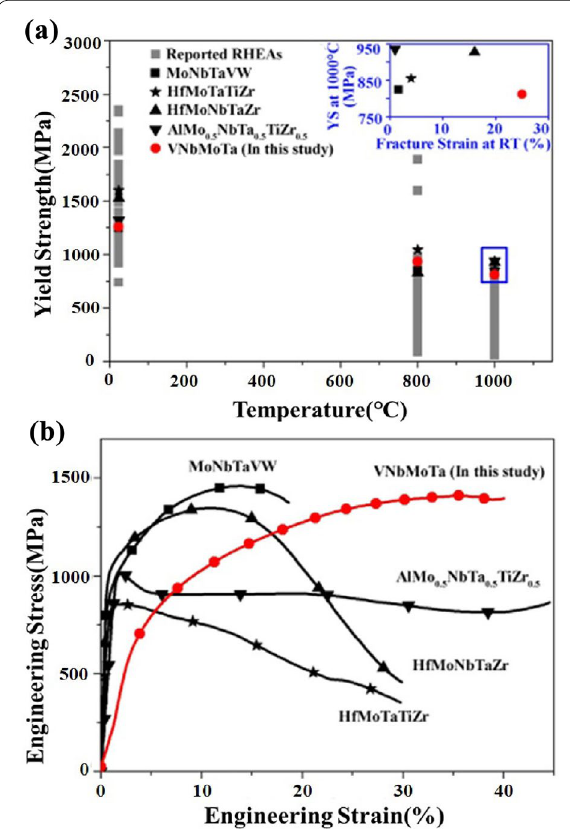
Figure 1 ( a ) Yield strengths of V1.0 RHEA and 67 RHEAs reported by far at different temperatures, where yield strengths at 1000 °C versus fracture strains at room temperature of alloys in the blue rectangle in ( a ). Stress-strain curves (1000 °C and 10 -3 s -1 ) of the five alloys are further compared in ( b ) [30]